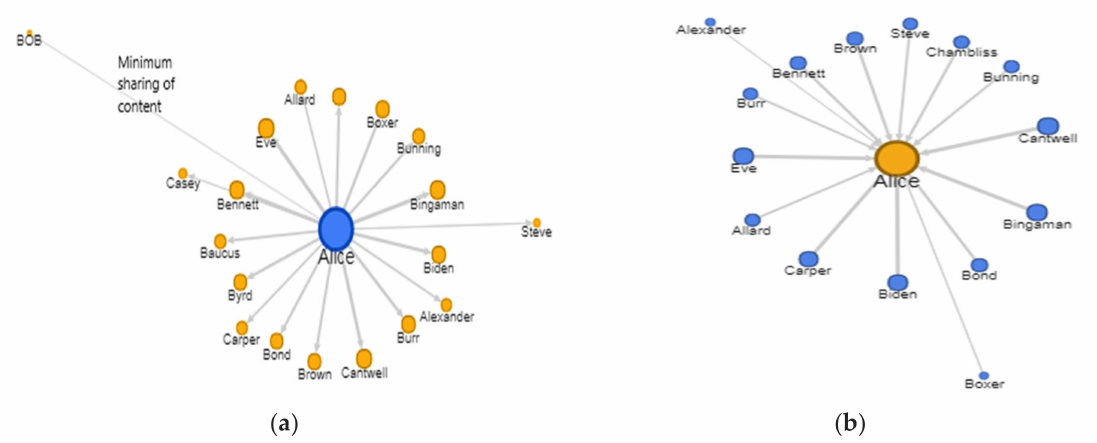
Figure 10. ( a ) The objects of the subject re-shared by her contacts. ( b ) The objects of other users re-shared by the subject.